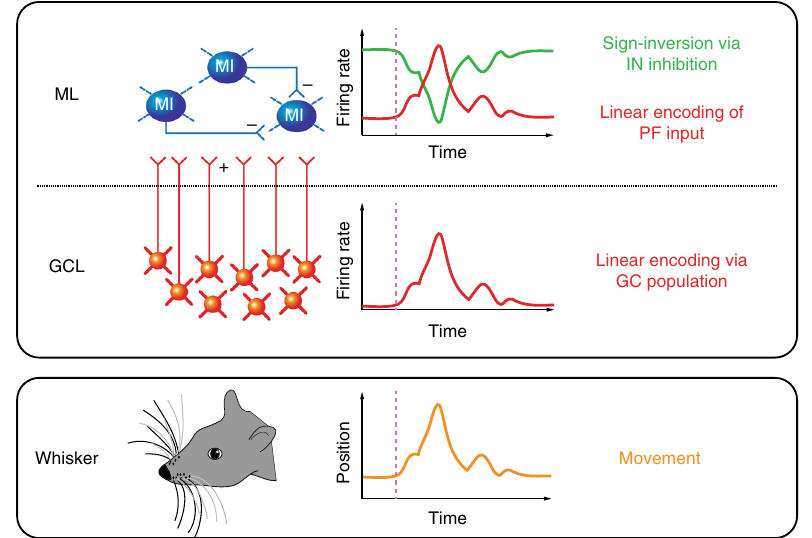
Fig. 8 Serial processing of whisking signals within the cerebellar cortex. Voluntary movement ( orange trace; lower box ) is encoded by GC populations via linear increases in spike output ( red trace; upper box ) to represent whisker position. Excitation from GCs (via PFs) drives elevated fi ring rates in the molecular layer during whisker movement. Local inhibitory networks mediate sign-reversed responses (decreasing activity during whisking) in neighbouring INs ( green trace; upper box ). GCL granule cell layer, ML molecular layer, MI molecular layer interneuron, PF parallel fi